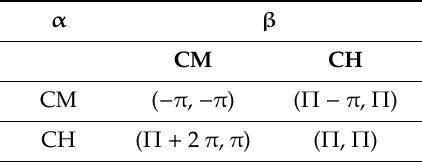
Table 5. The payo ff matrix of nodes to be